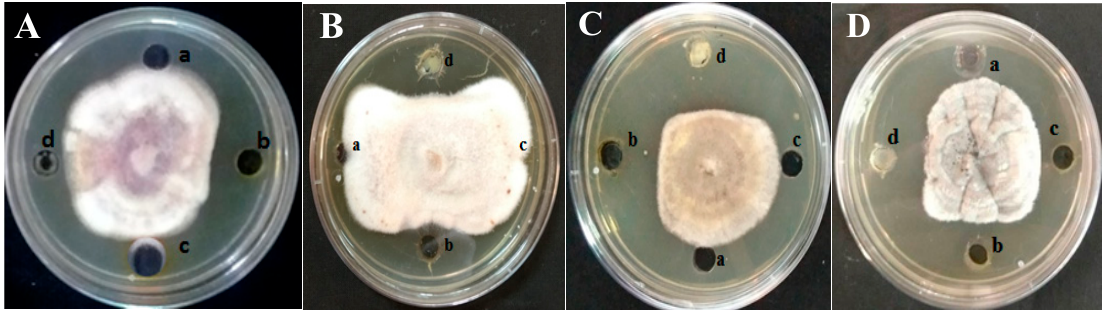
Figure 1. Growth inhibition of ( A ) Fusarium thapsinum , ( B ) Epicoccum sorghinum , ( C ) Alternaria alternata and ( D ) Curvularia lunata pathogens by crude methanolic extract of Eclipta alba at 120 mg/mL concentration. (a) Control, (b) Methanolic extract of E. alba , (c) DMSO, (d) Bavistin.